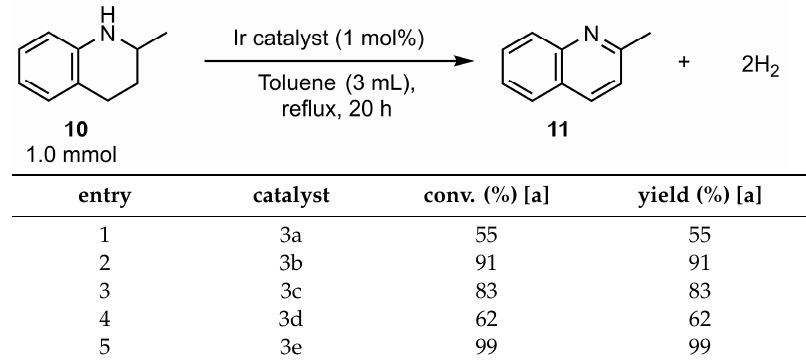
Table 4. Catalytic activity of iridium complexes ( 3 ) in the dehydrogenation of 10 .